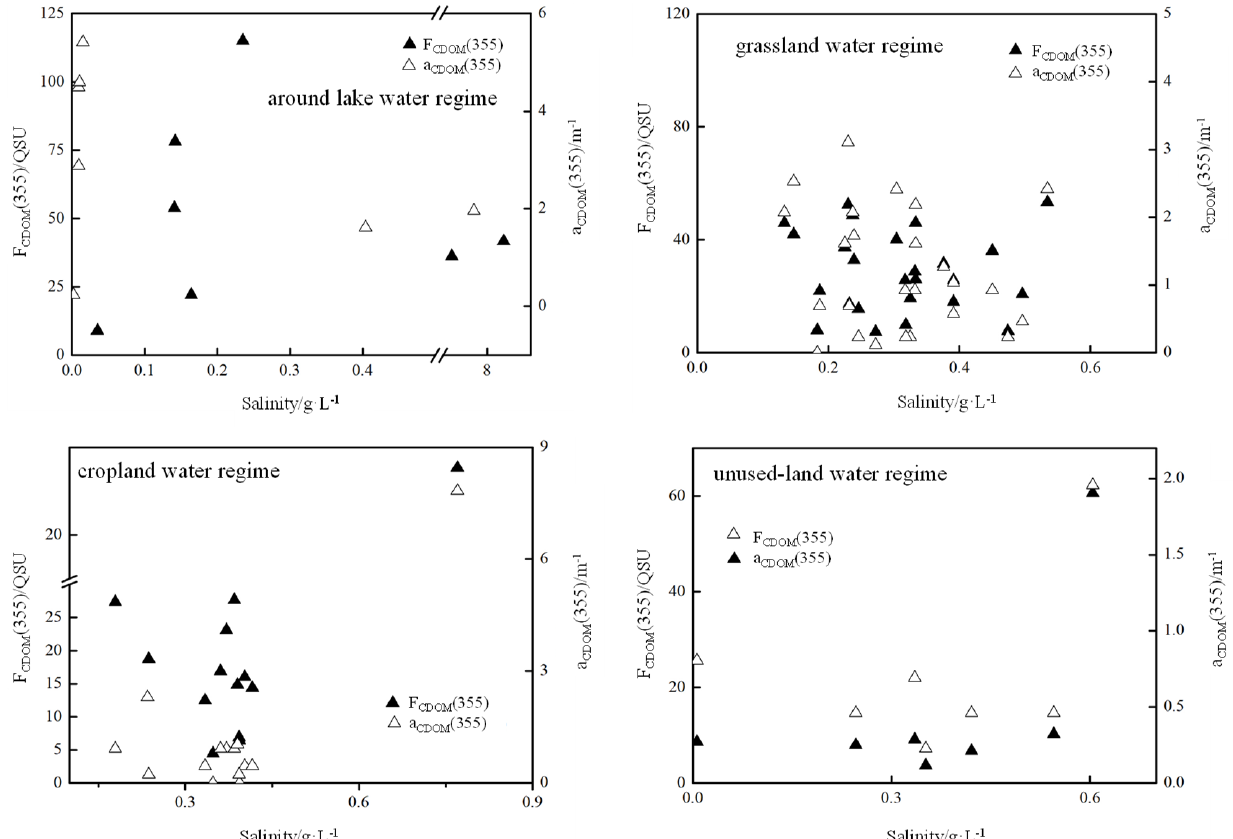
Figure 3. Variation of CDOM absorption and fluorescence with salinity along the axial transect. Empty triangles represent CDOM absorption, filled triangles represent CDOM fluorescence for different land use water regimes.